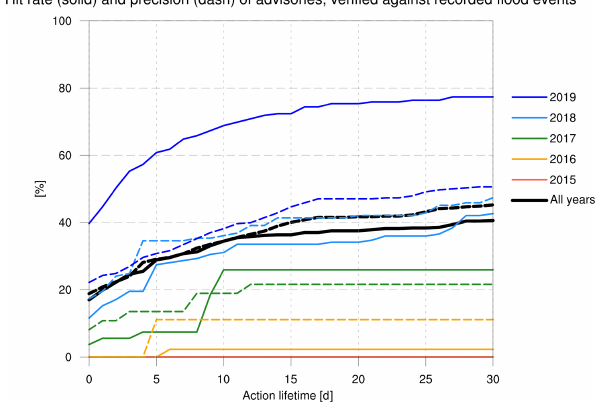
Figure 7. Skill statistics of the advisories when verified against ob- served flood events at county level. The hit rate shows the percent- age of events which were preceded by an advisory in that county (solid line), whilst the precision shows the percentage of county warnings which were followed by an event (dashed line; note that precision is equivalent to 100% minus the false-alarm ratio). Statis- tics are calculated for all years (black line) and each year separately (coloured lines) across a range of “action lifetimes”, such that theo- retical action based on each advisory is assumed to have a lifetime so is still considered a “hit” as long as the flood event occurs within the lifetime of the